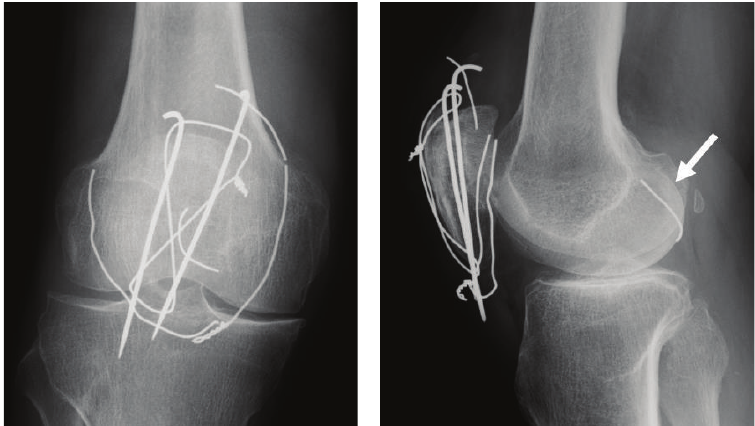
Figure 3: Plain radiographs of the right knee show a fragment of wire migrated into the posterior compartment of the right knee